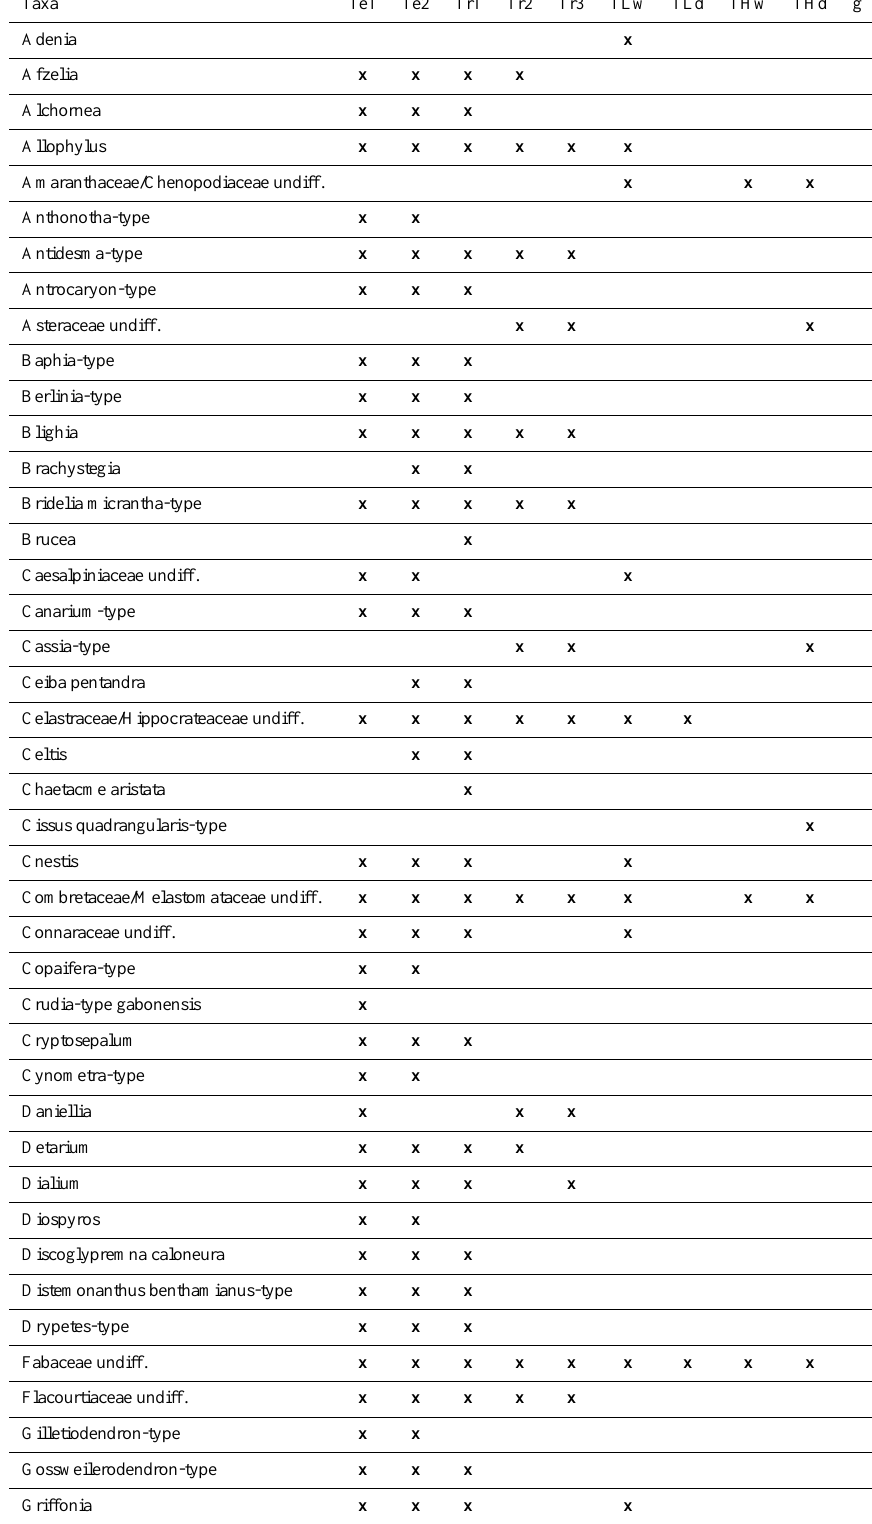
Table 2. Allocation of the pollen taxa identified in the Barombi Mbo sequence to the plant functional types (PFTs) used for biome recon-